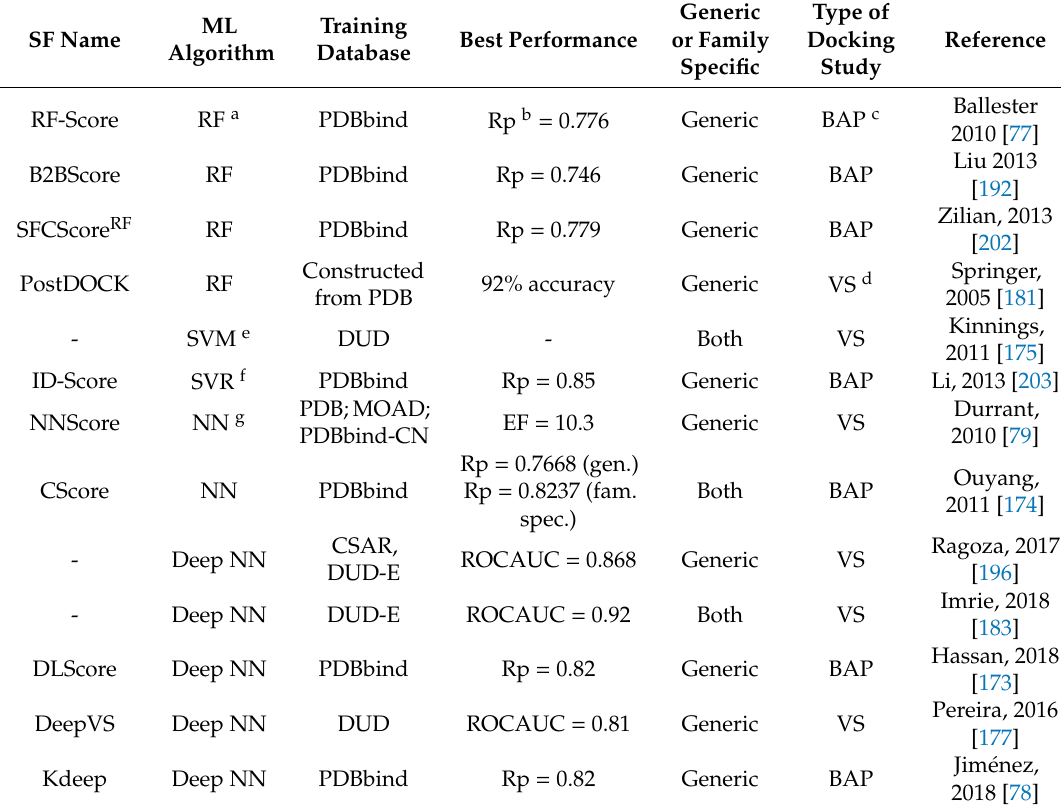
Table 4. Recent developments using machine learning (ML) algorithms in molecular